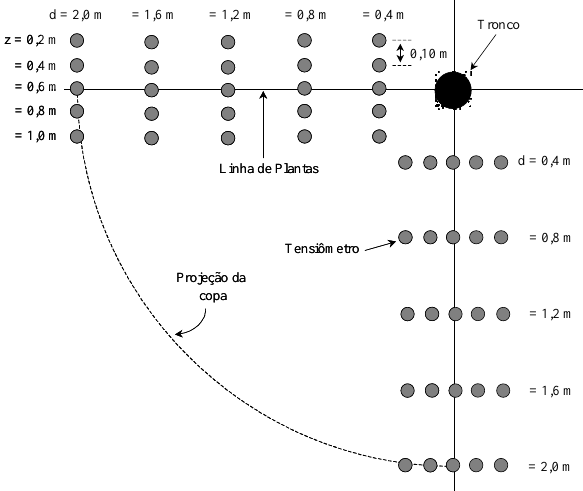
Figura 1. Distribuição dos tensiômetros instalados sob a copa da planta de citros: z = profundidade do solo, d = distância